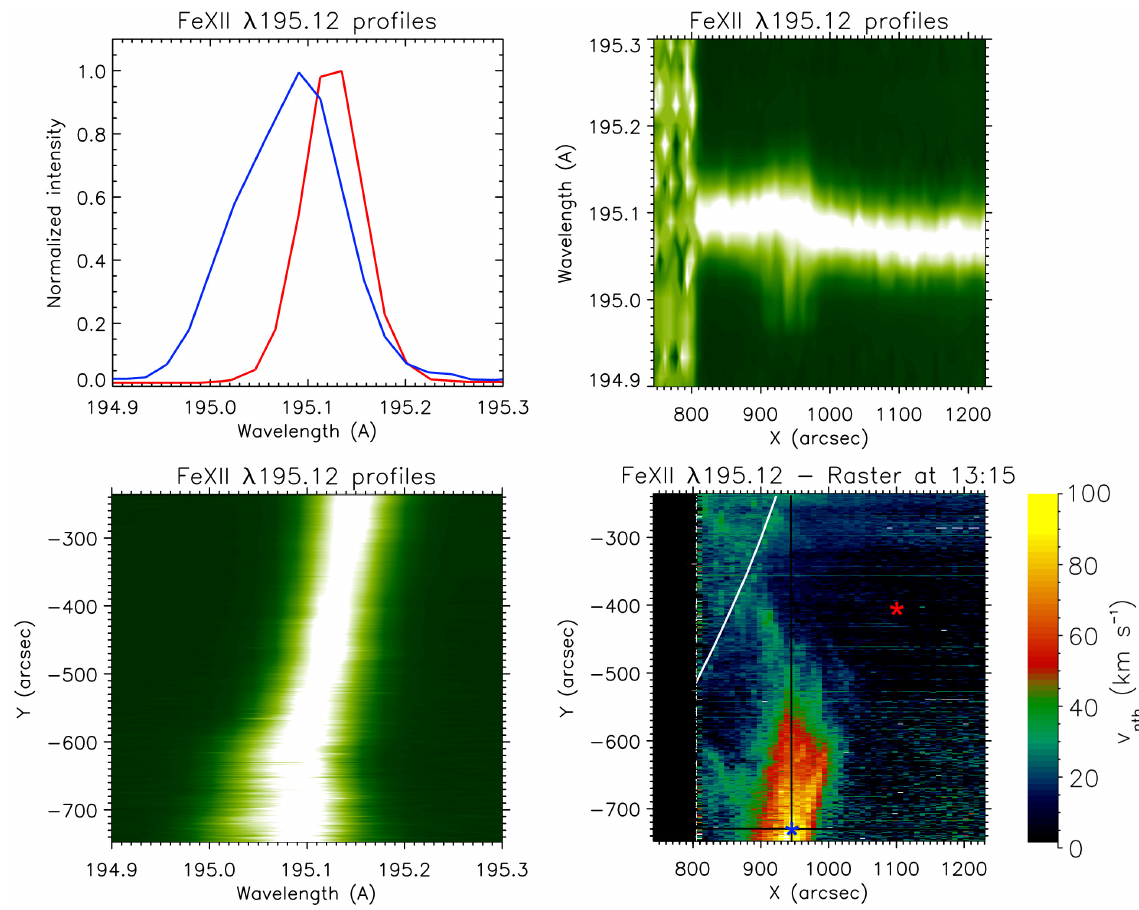
Fig. 6. Top left: a comparison between two Fe XII λ 195.12 line profiles acquired along the eruption path (blue line) and in the surrounding corona (red line). The corresponding positions where these two profiles have been acquired are outlined in the bottom right panel of this figure by a blue and a red asterisk, respectively. Top right and bottom left: normalized Fe XII λ 195.12 line profiles plotted along a detector row (top right) and a column (bottom left) cutting across the coronal region crossed by the prominence eruption (profiles shown in these panels are not corrected for the EIS slit tilt and the HINODE spacecraft motion; see text). Bottom right: a map showing the Fe XII λ 195.12 non thermal line broadening in the raster acquired immediately after the eruption (see Fig. 4 and bottom left panel in Fig. 5). Vertical and horizontal black lines show the detector column and row relative to the profiles plotted in the top right and bottom left panels.